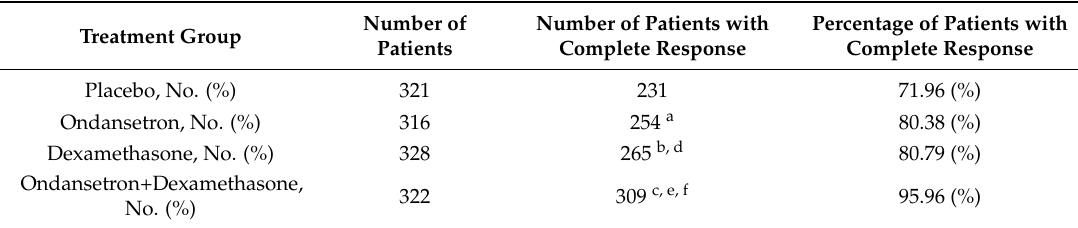
Table 2. Proportion of patients with complete response during the first 24 hours after